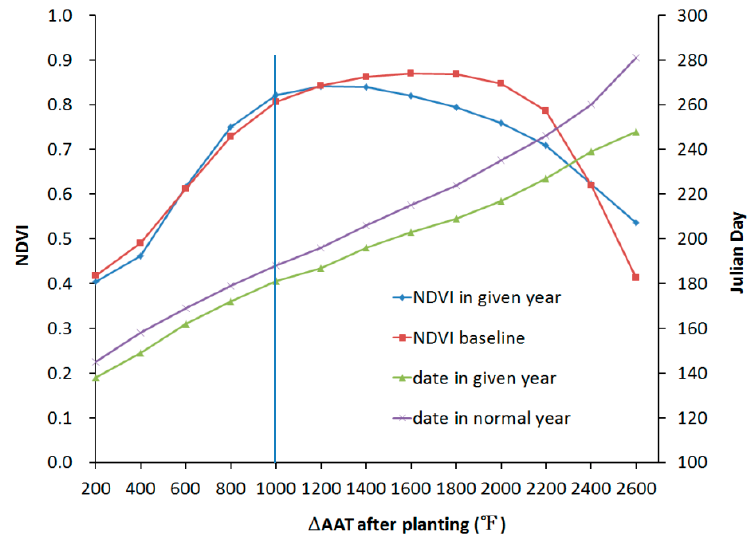
Figure 8. The NDVIs and the needed Julian dates corresponding to the Δ AATs of the given year and the normal reference year. The baseline (normal year) and the given study year NDVI curves (corn phenology) are in red and blue respectively. The purple and green curves represent the dates that crops reach the same growth stages (or the same Δ AAT) in the normal year and the given study year, respectively. For a given Δ AAT (or growth stage), comparing two NDVI values gives the indication of the crop growth condition while comparing Julian days provides information of timing of reaching at the given crop growth stage.